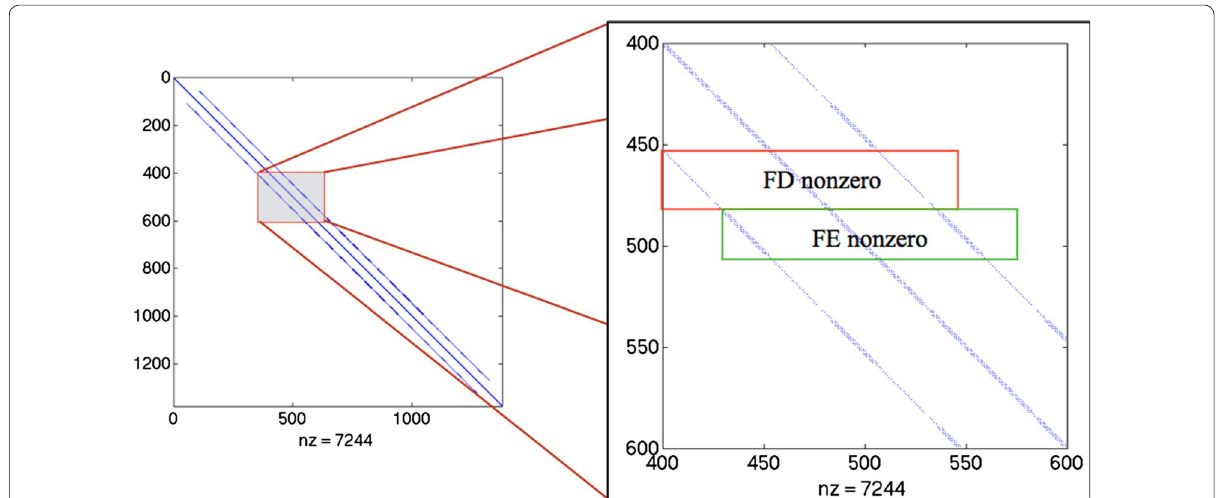
Fig. 4 Sparsity pattern in the matrix derived by the hybrid FD–FE method. The cluster of FE nonzeros is inserted in the coefficient matrix